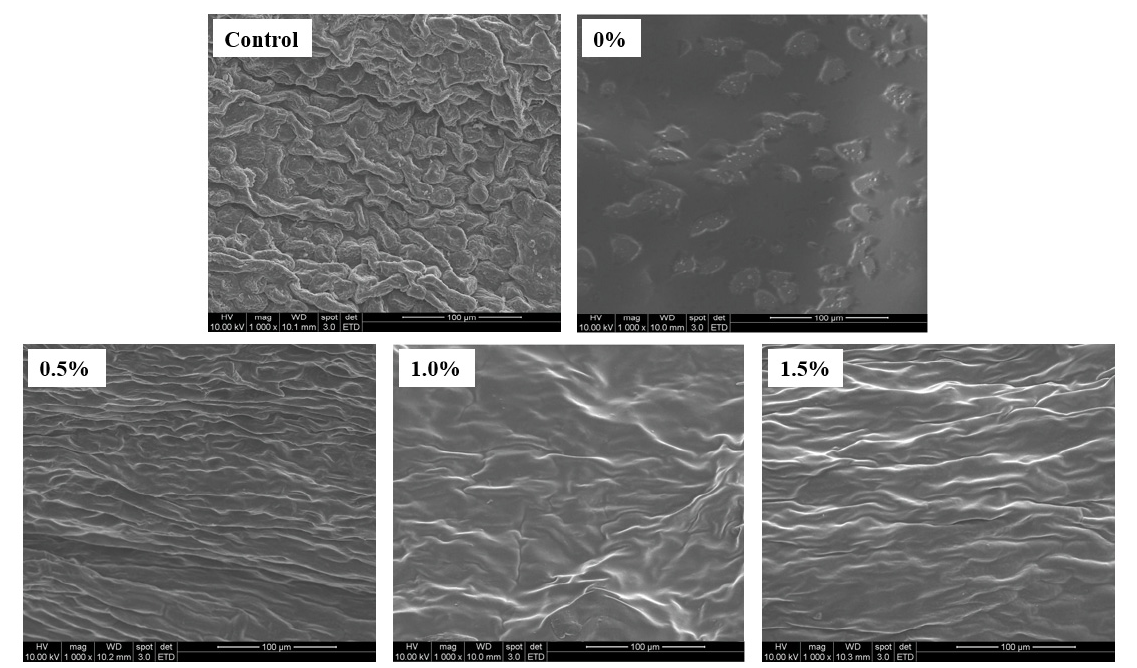
Figure 6. Surface morphological properties of bananas coated with different concentrations of D-limonene nanoemulsion edible film. Scale bar represents 100 μ m.